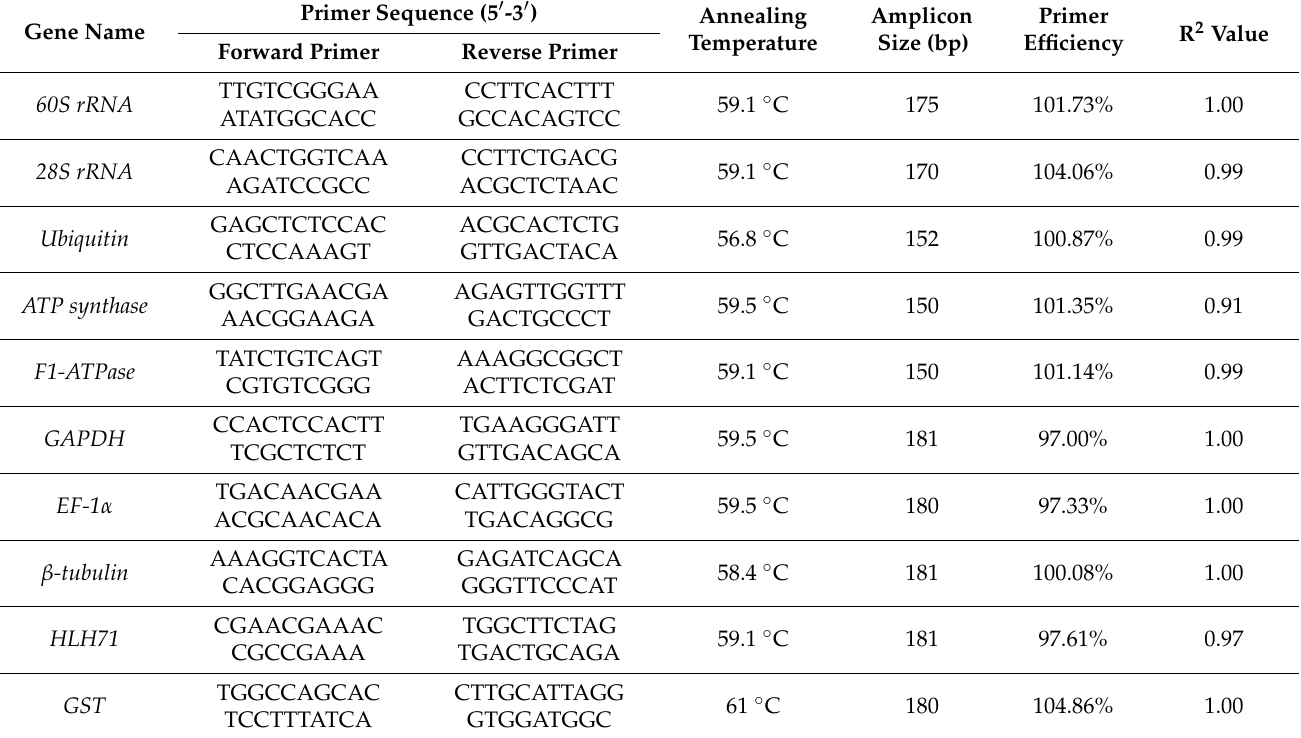
Table 1. Primer information of the candidate reference